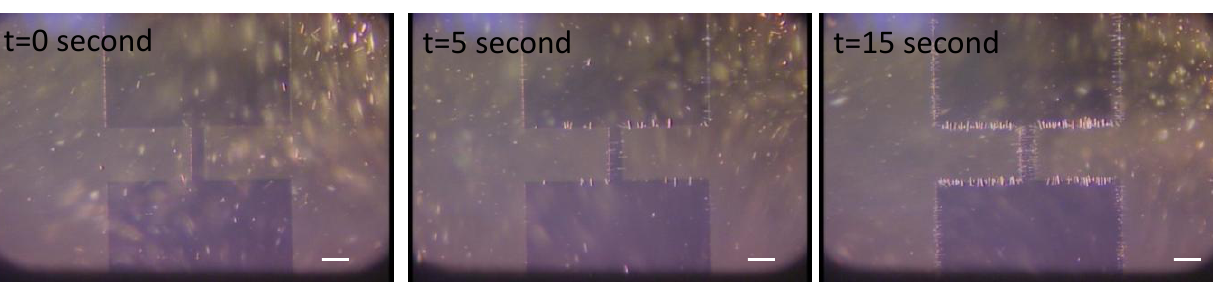
(peak to peak voltage) at 5 MHz. The pp